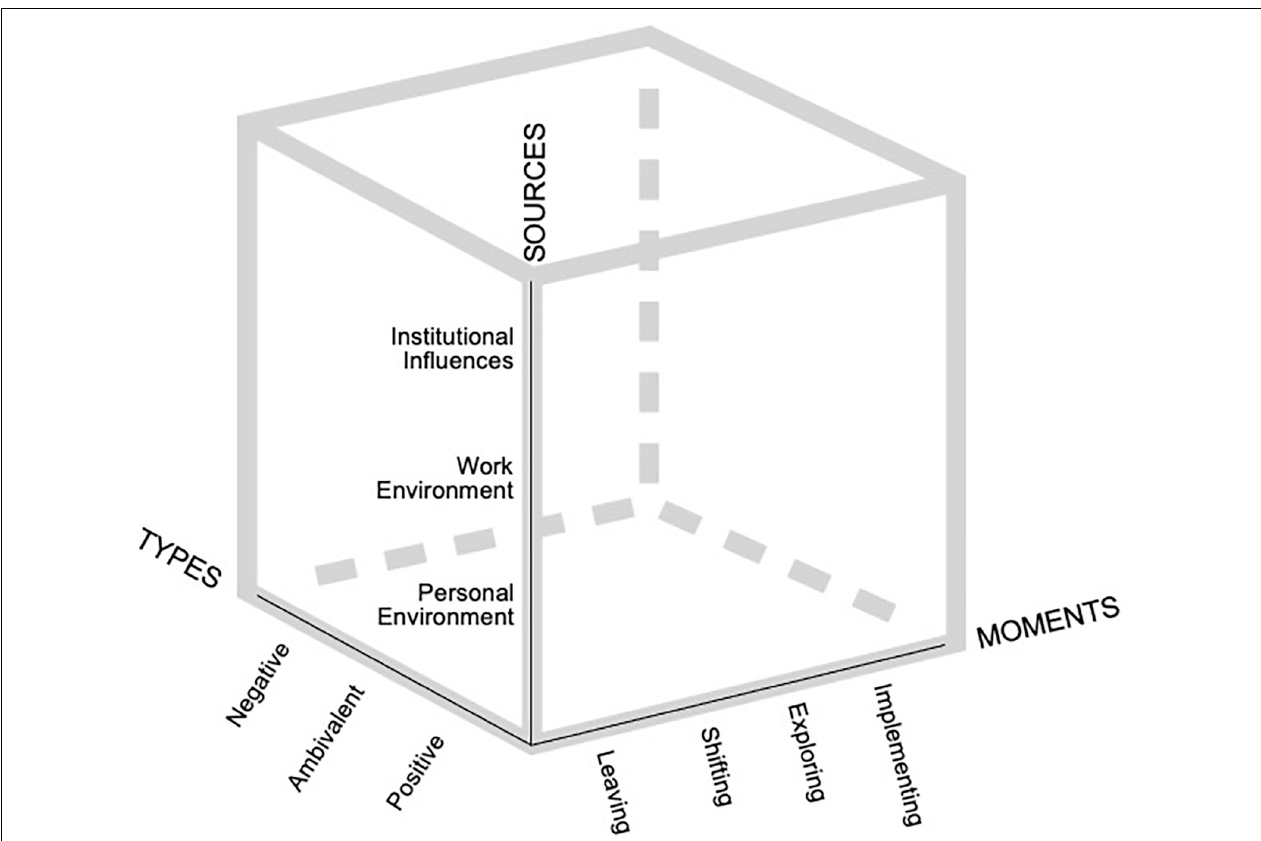
FIGURE 1 | Visual representation of the structuring themes (all caps) and